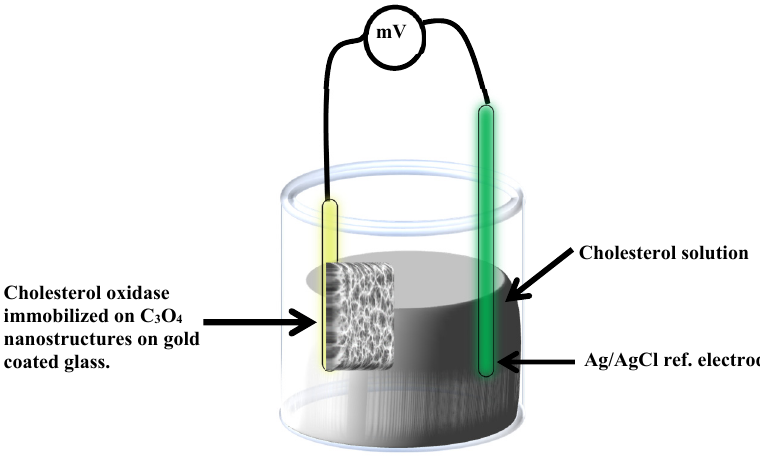
Figure 10. Illustration for the present cholesterol biosensor adopting the potentiometric measurement approach using cholesterol oxidase immobilized cobalt oxide